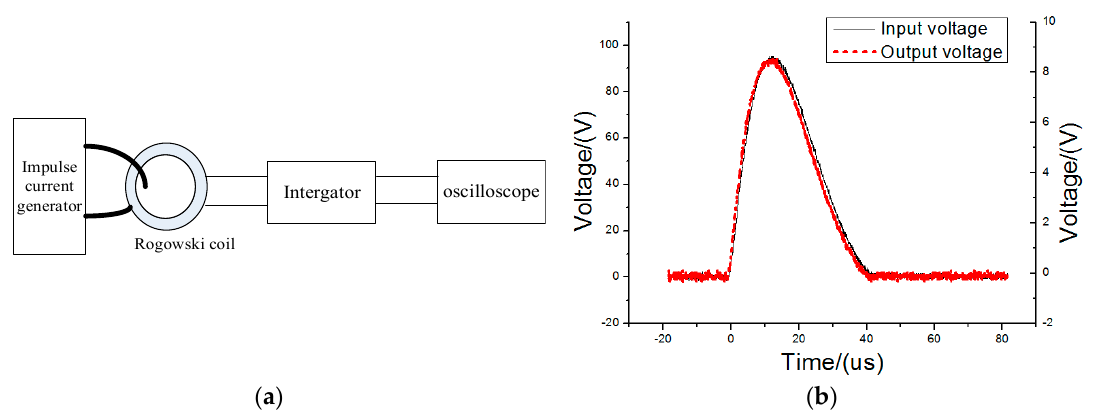
Figure 11. The verification of the PCB Rogowski Coil. ( a ) Experimental linearity circuit; ( b ) Waveform